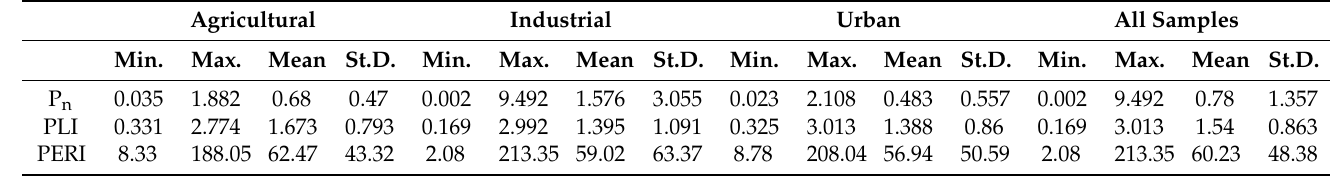
Table 2. Descriptive statistics of P n , PLI, and PERI values in different land-use soil. Agricultural Industrial Urban All Samples